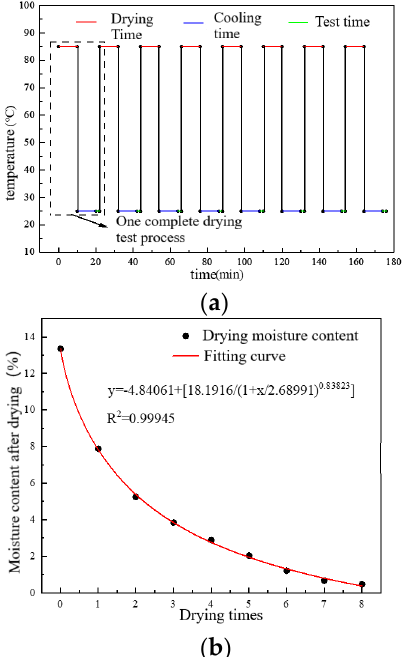
Figure 2. ( a ) Drying test path; ( b ) moisture content of successive drying results.